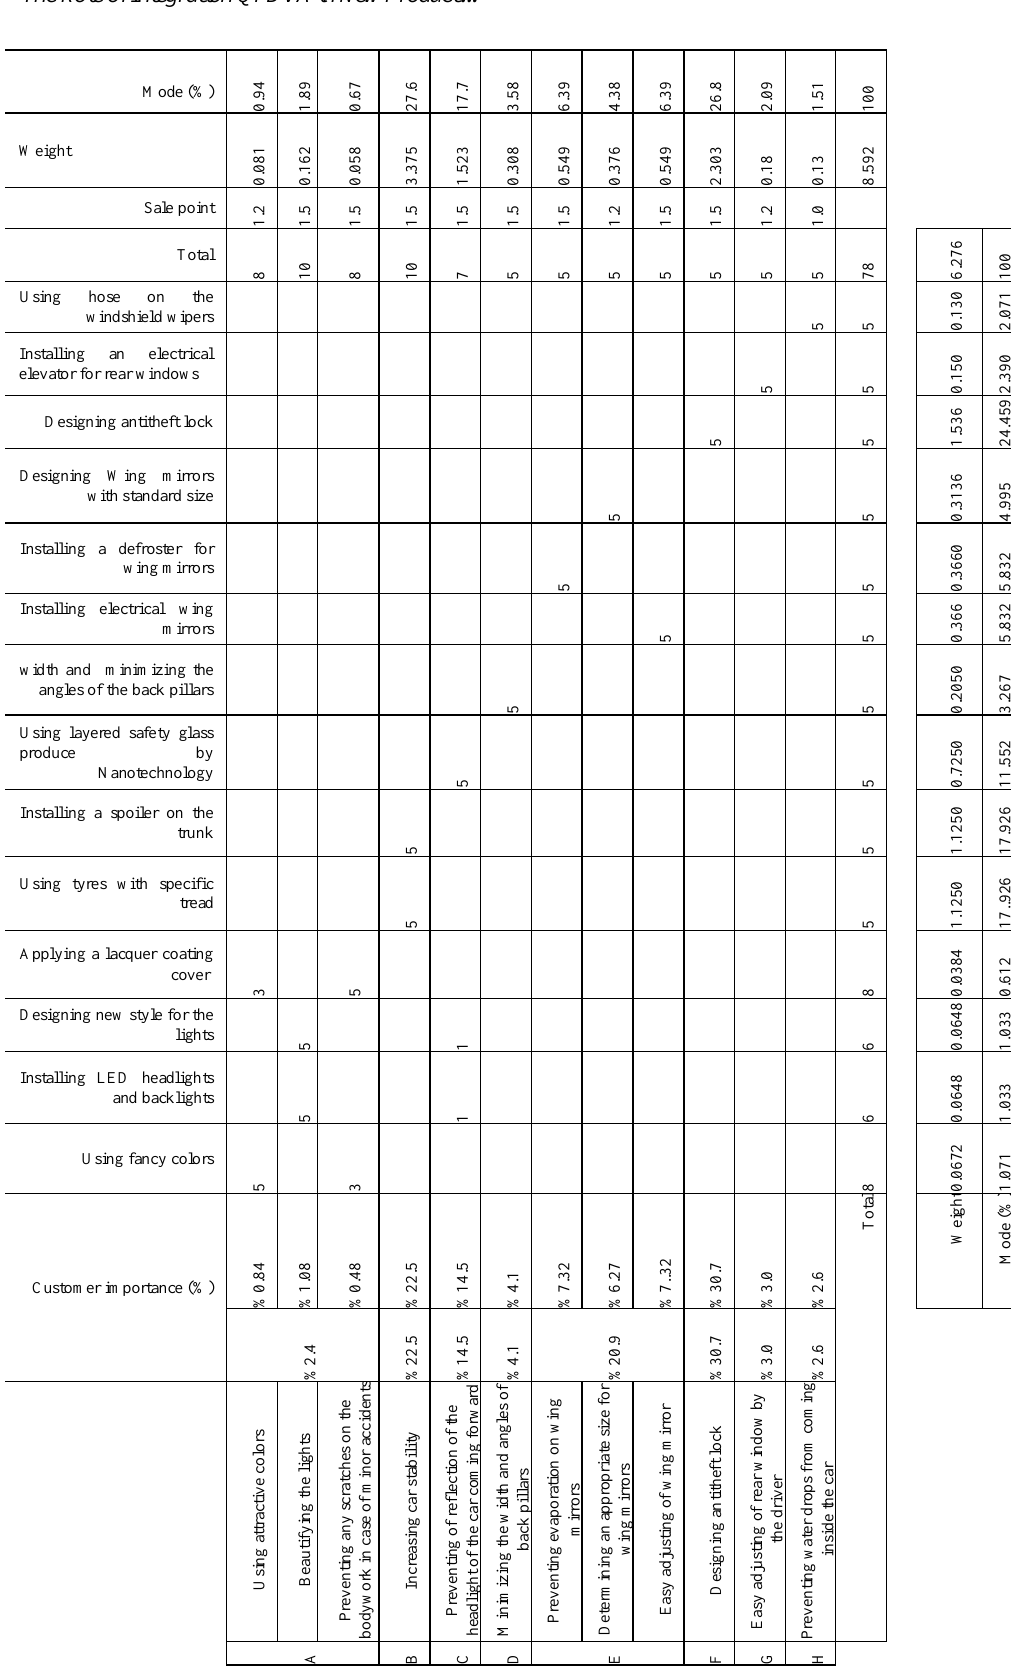
Figure 11. The quality house of completed QFDVA for